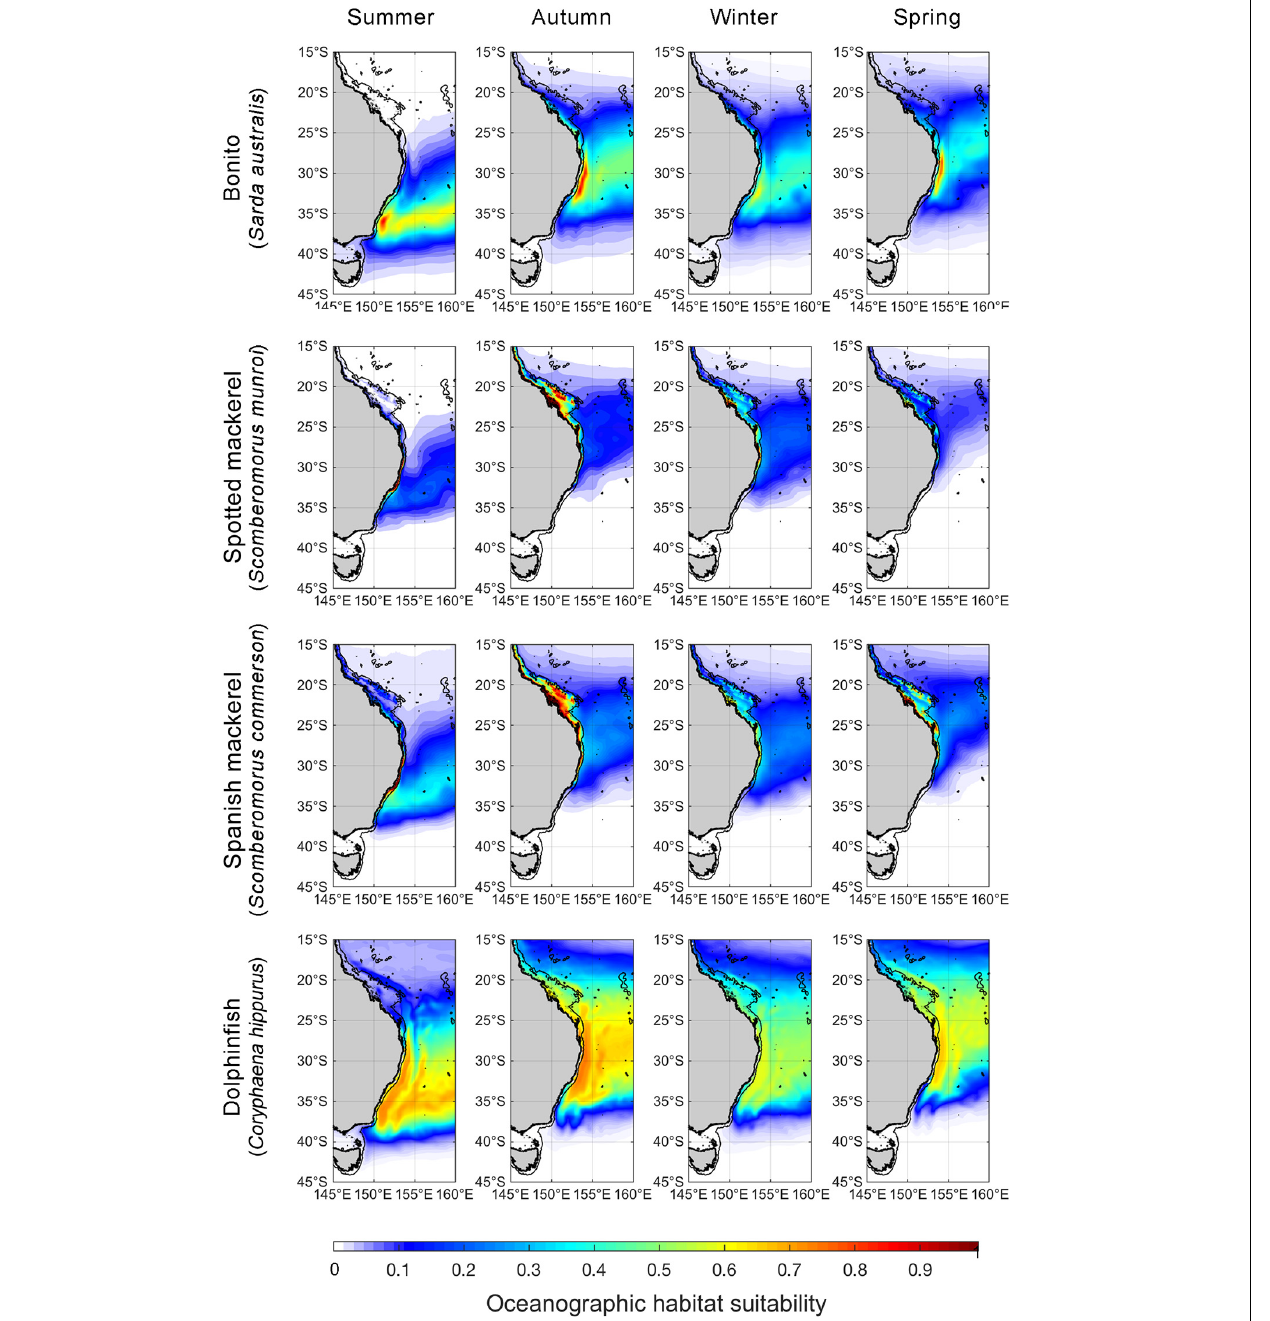
FIGURE 2 | Spatial predictions of seasonal oceanographic habitat suitability off eastern Australia. Monthly spatial predictions were averaged for the period encompassing January 1998–December 2018 and seasonally aggregated (Summer = December to February, Autumn = March–May, Winter = June–August, Spring = September–November). The black line offshore of the coastline denotes the continental shelf-break (i.e., 200-m isobath). We note that although spatial predictions of oceanographic habitat have been extrapolated beyond the continental shelf-break to improve visual communication in this figure, range shift analyses were only undertaken on oceanographic habitat nearshore of the continental